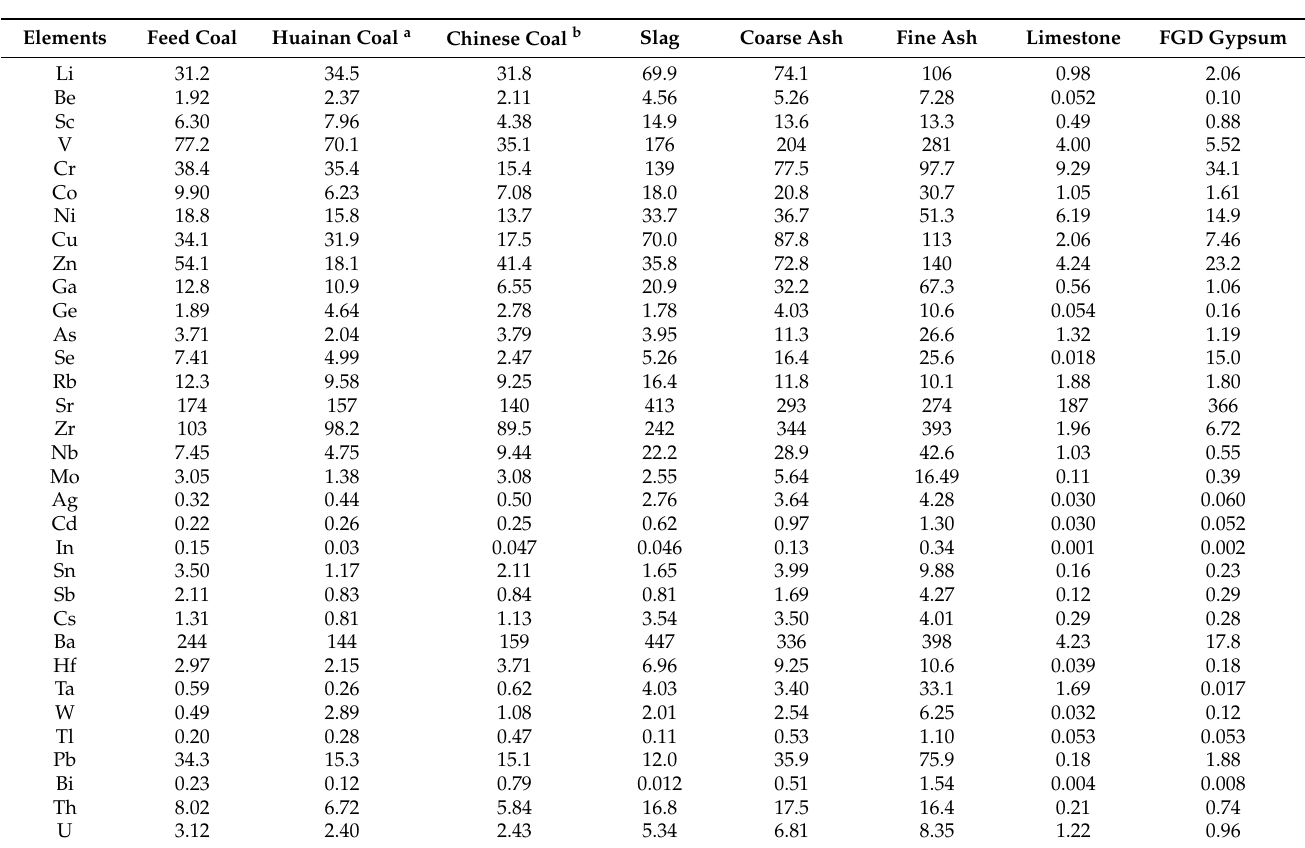
Table 2. Trace element concentrations in feed coal and its by-products from the WN power plant (units: mg/kg on an air-dried